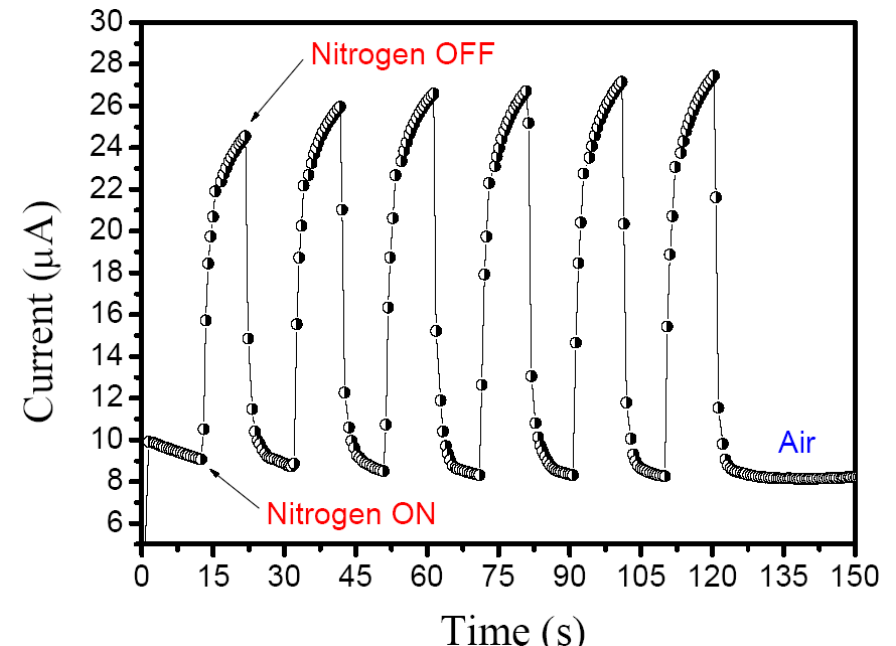
Figure 4. Response of PEDOT-PSS doped with MR upon periodic exposure to nitrogen an applied 2.50 VDC bias in room temperature with 46 % relative humidity